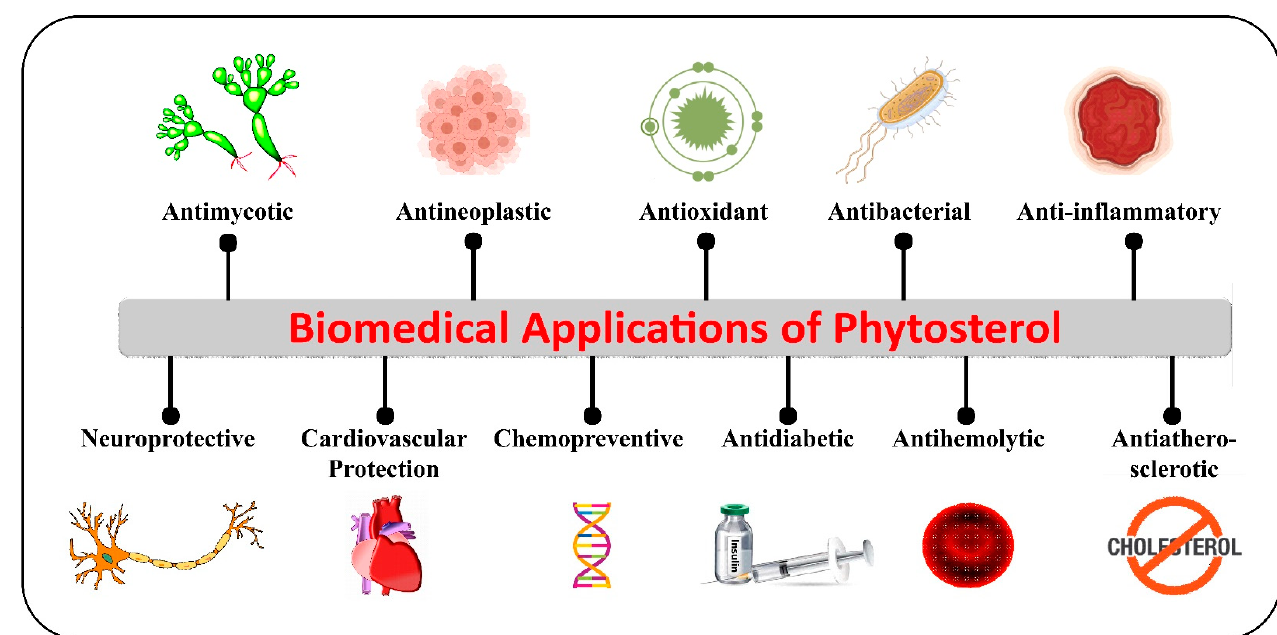
Figure 3. Biological properties and biomedical applications of phytosterols.